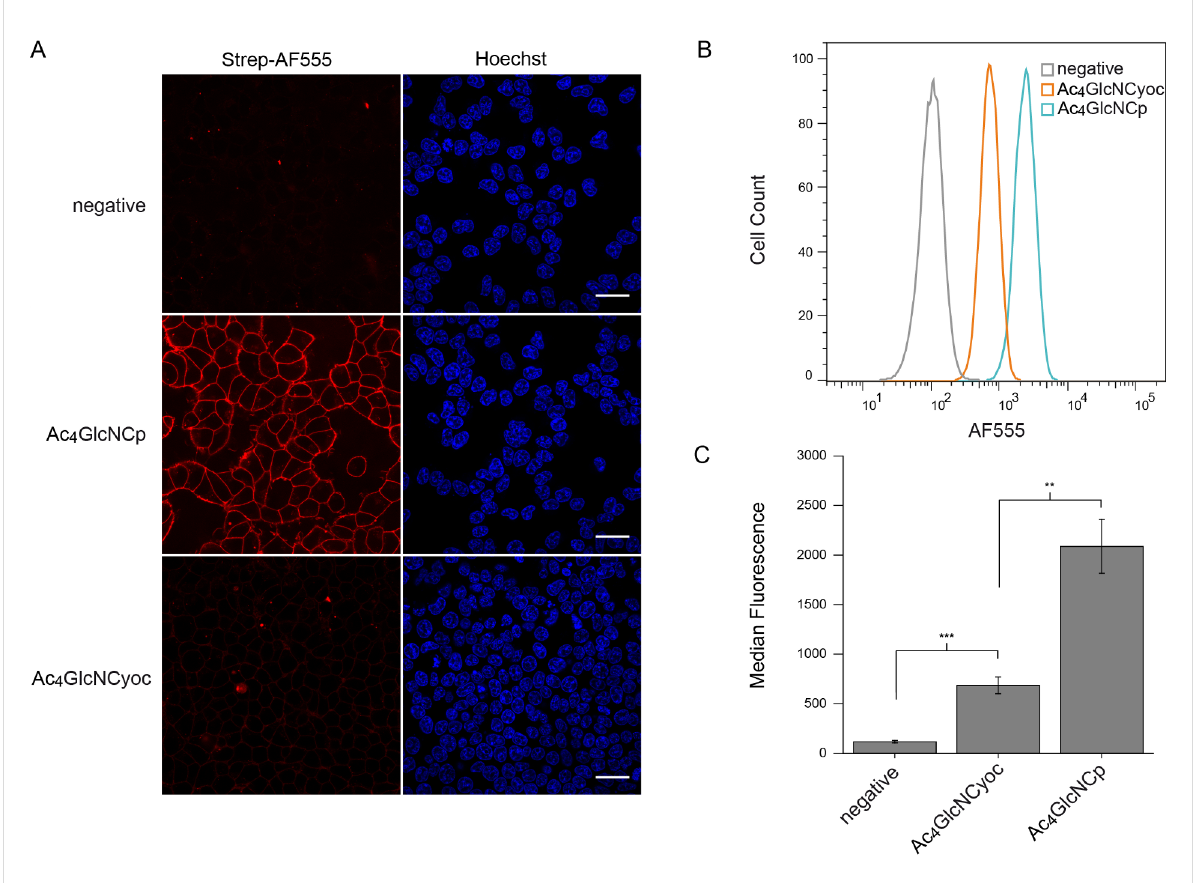
Figure 6: HEK 293T cells were grown with 50 μ M (A) or 100 μ M (B) Ac 4 GlcNCp, Ac 4 GlcNCyoc or DMSO only (negative control) for 48 h. Cells were incubated with Tz-biotin (500 μ M) for 3 h (A) or 1 h (B/C) at 37 °C followed by incubation with strep-AF555. A) Results from confocal fluorescence microscopy. Nuclei were stained with Hoechst 33342. Scale bar: 30 μ m. B) Histogram from flow cytometry experiments. C) Median fluorescence from three independent flow cytometry